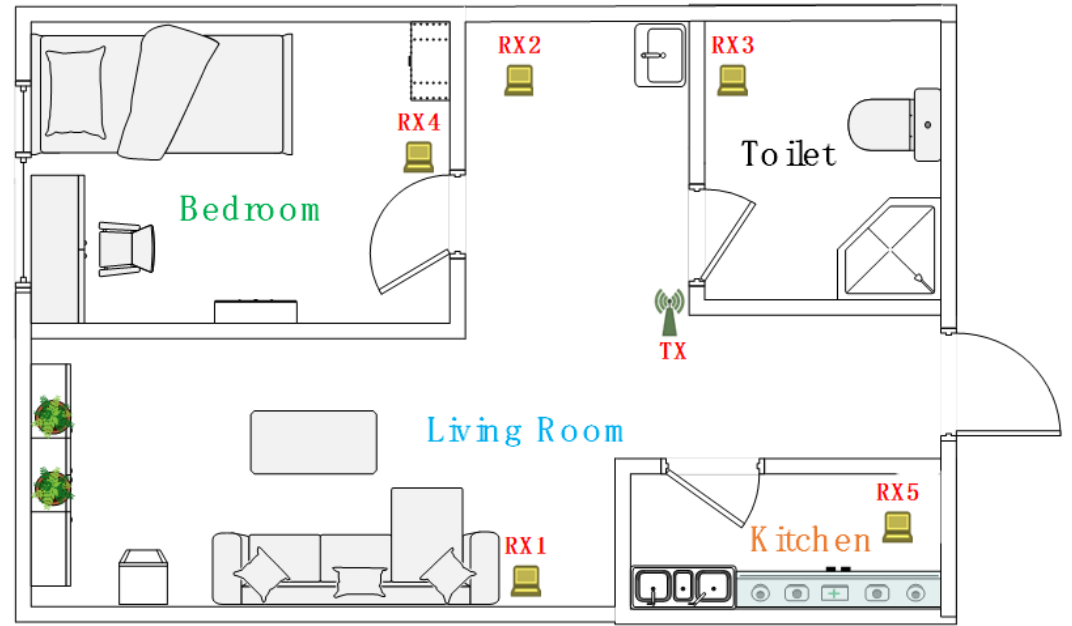
Figure 13. The layout of multi-room smart home environment.